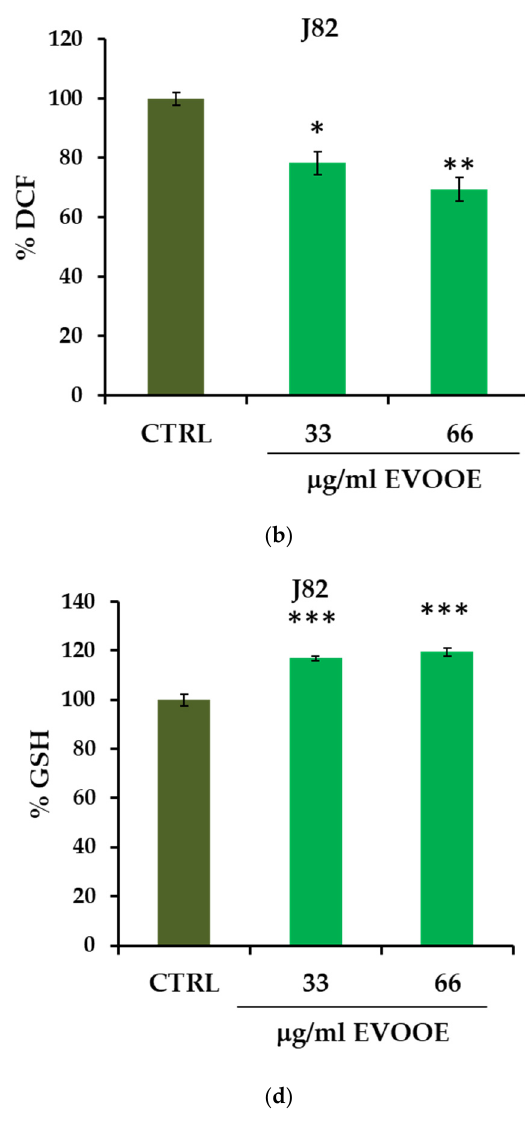
Figure 6. Antioxidant effect of EVOOE in RT112 and J82 cells. Intracellular ROS were measured as DCF fluorescence; RT112 ( a ) and J82 ( b ) cells were stimulated with the indicated concentration of EVOOE for 30 min. Bar graphs represent means of three separate experiments ± s.e. Symbols indicate significance: p < 0.05 (*) and p < 0.005 (**) with respect to CTRL. GSH content was measured after the treatment of RT112 ( c ) and J82 ( d ) cells with the indicated concentration of the extract for 3 h and compared to untreated samples. Bar graphs represent means of three separate experiments ± s.e. Symbols indicate significance: p < 0.05 (*), p < 0.005 (**), and p < 0.0001 (***) with respect to CTRL.